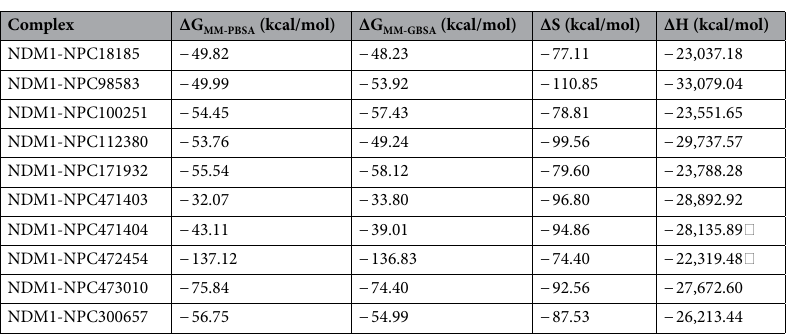
Table 5. Thermodynamic parameters of binding ligands to NDM.